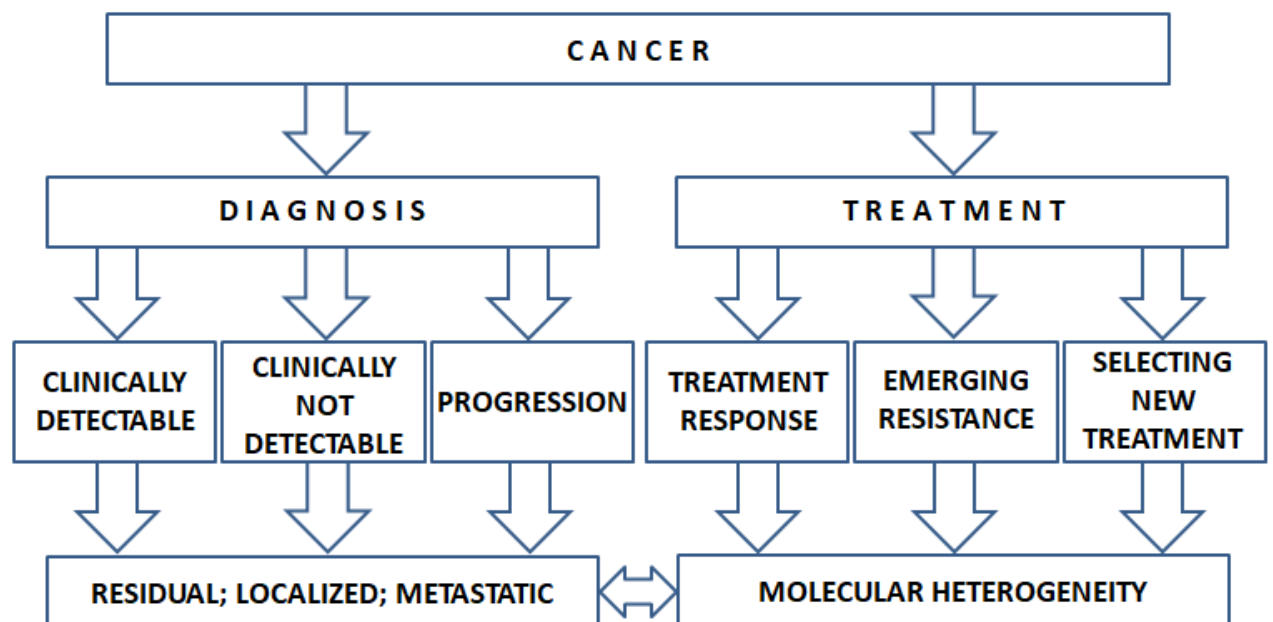
Figure 1. The potential use of ctDNA in clinical decision making.